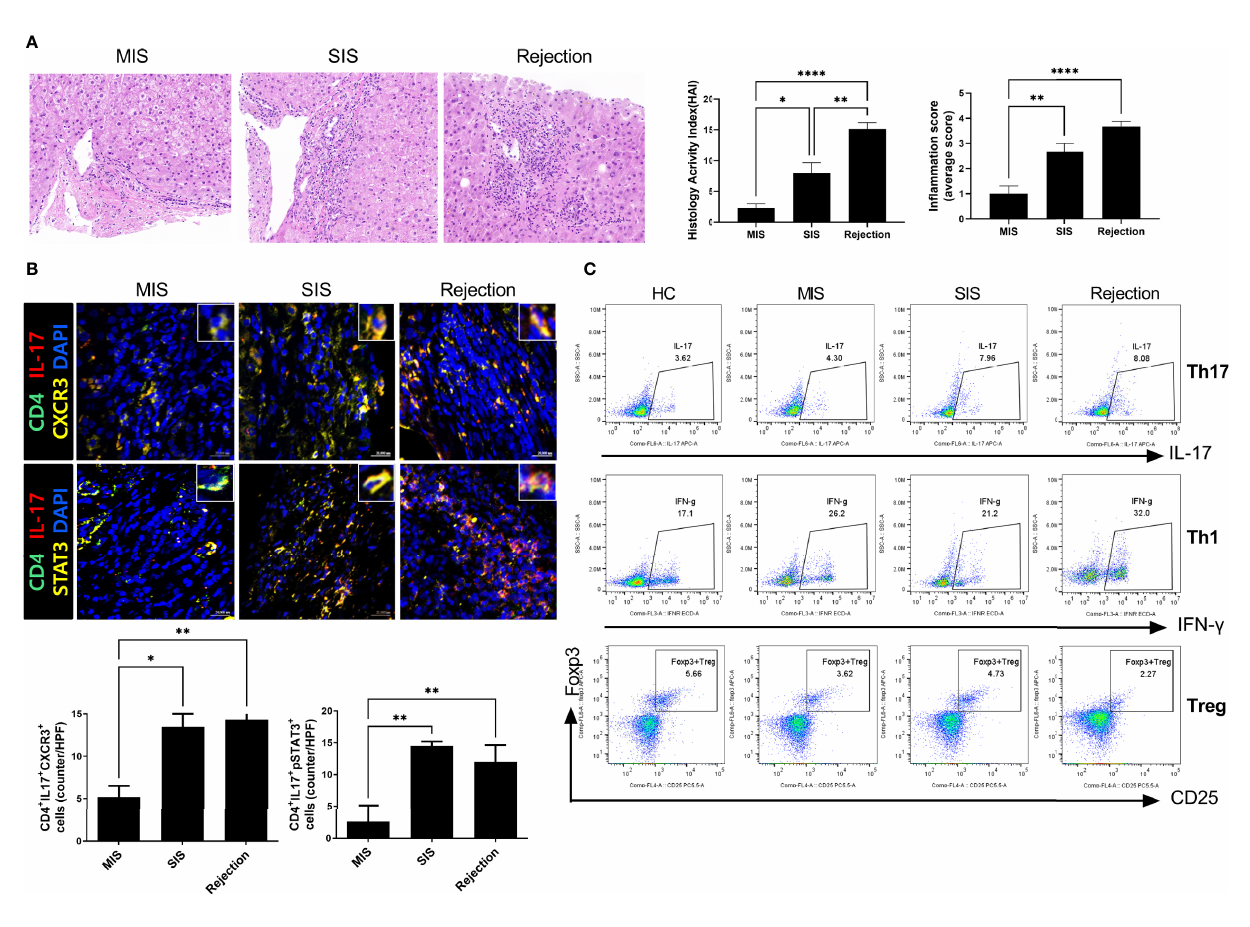
FIGURE 2 | Liver histologic and T-cell subset analysis of LT patients. (A) Representative liver histology of LT patients stained with H&E. (B) Representative confocal images of CD4-IL-17, CXCR3, and STAT3 in liver histology of LT patients. The number of positive cells was counted in fi ve independent liver tissues. (C) Plots from representative experiment show the frequencies of IL-17 + (Th17), IFN- g + (Th1), and CD25 + FoxP3 + (Treg) cells among CD4 + T cells in PBMCs of LT patients. Values represent the mean ± SD for six mice per group from at least three independent experiments. * P < 0.05, ** P < 0.01, **** P < 0.0001. H&E, hematoxylin and eosin; LT, liver transplantation; MIS, mild in fl ammation in stable; SIS, severe in fl ammation in stable; HC, healthy control; PBMC, peripheral blood mononuclear